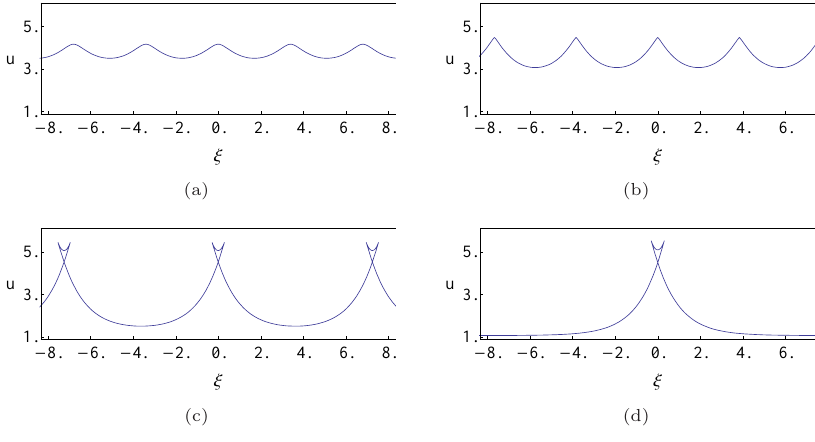
Figure 1. The smooth periodic wave, periodic cusp wave, periodic cusp loop wave and cusp loop solitary wave of Eq. (1.1) with c = 20 and g = 20: (a) ϕ 0 = 3 . 5, (b) ϕ 0 = ϕ √ c , (c) ϕ 0 = 1 . 5, (d) ϕ 0 = ϕ 2